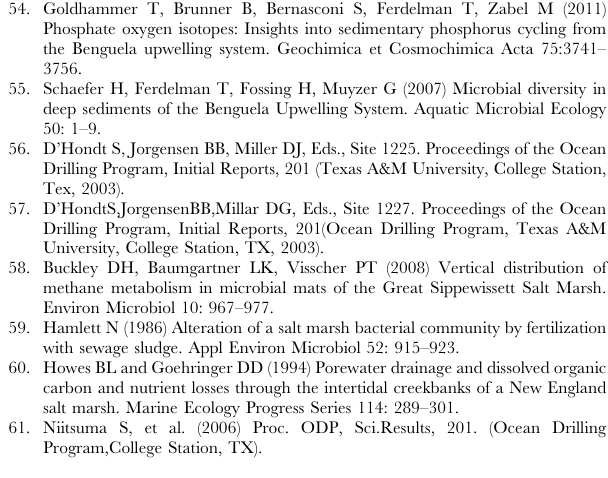
table of contents. 47. Pacini E, Guarnieri M, Nepi M (2006) Pollen carbohydrates and water content during development, presentation, and dispersal: a short review.